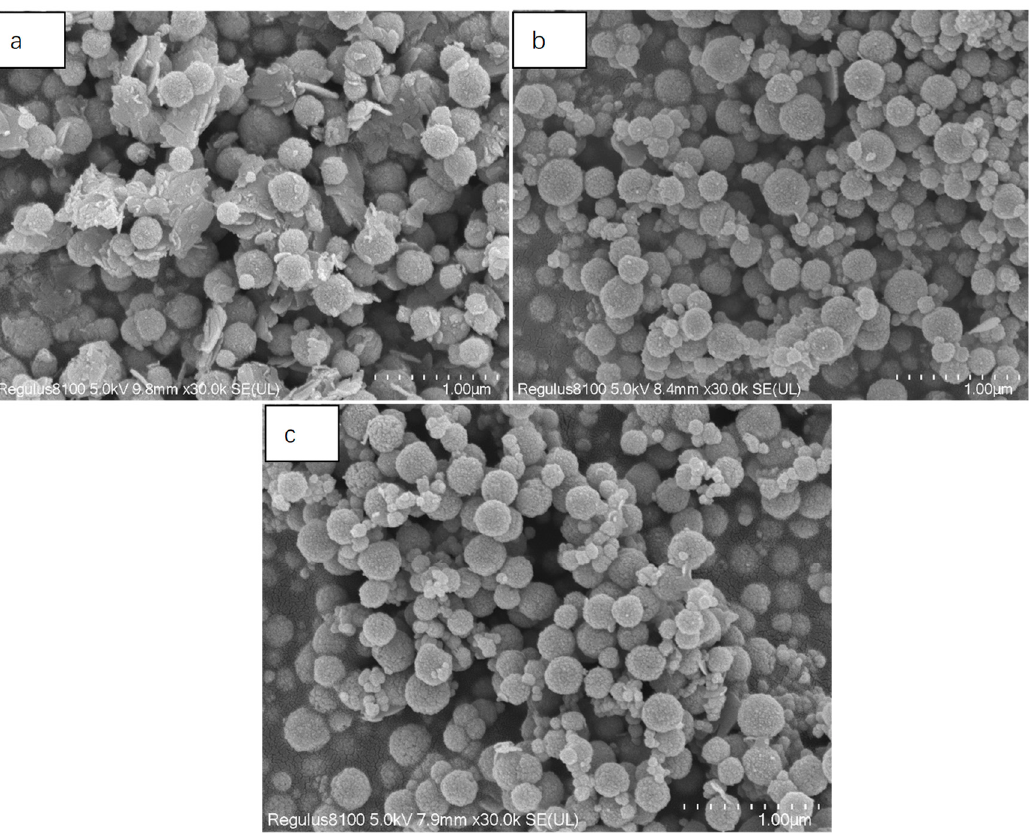
Figure 10. SEM image of Fe 3 O 4 synthesized by microwave. Reaction time: ( a ) 2 h; ( b ) 3 h; and ( c ) 4 h.